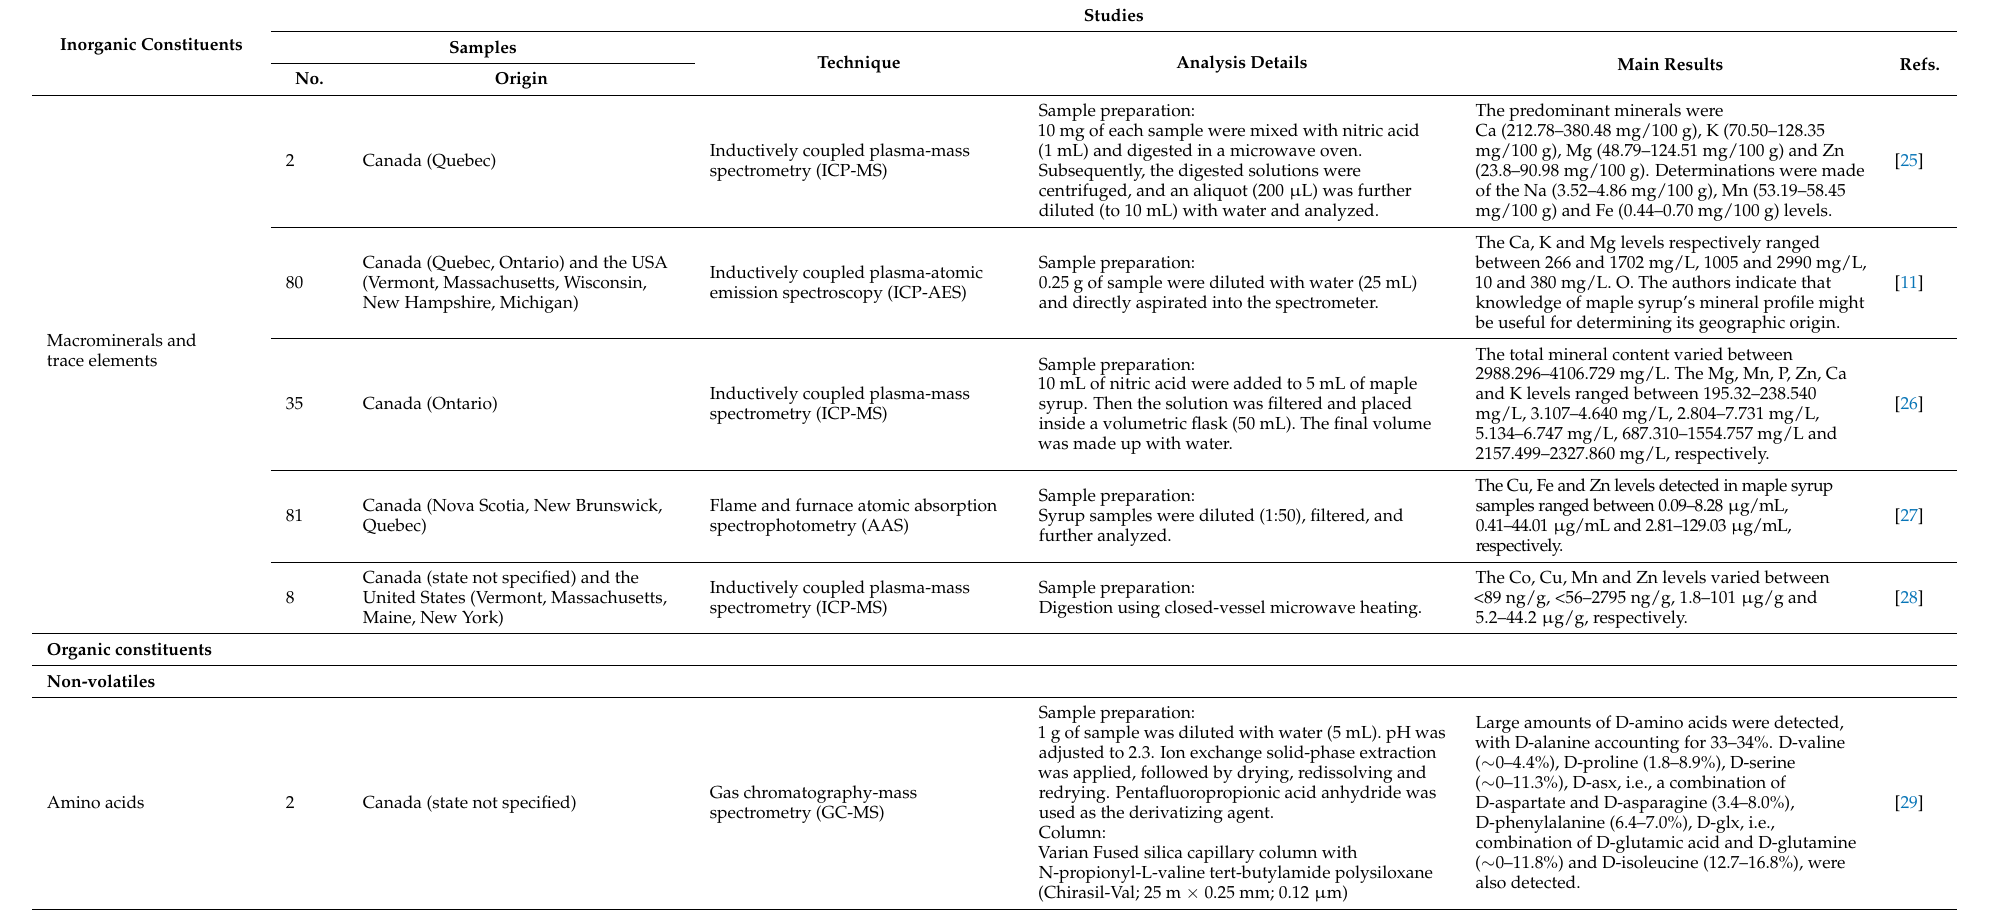
Table 2. Chemical analysis of inorganic and organic constituents of maple